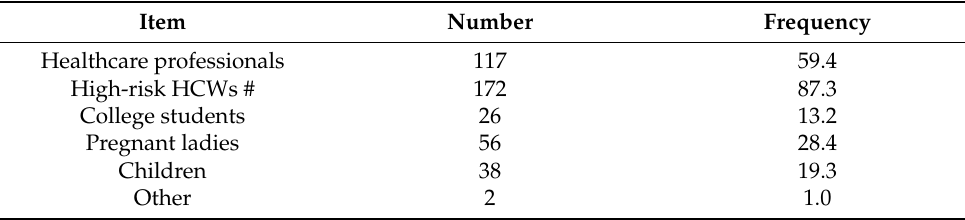
Table 2. Participants’ prioritization of Monkeypox disease vaccine administration.